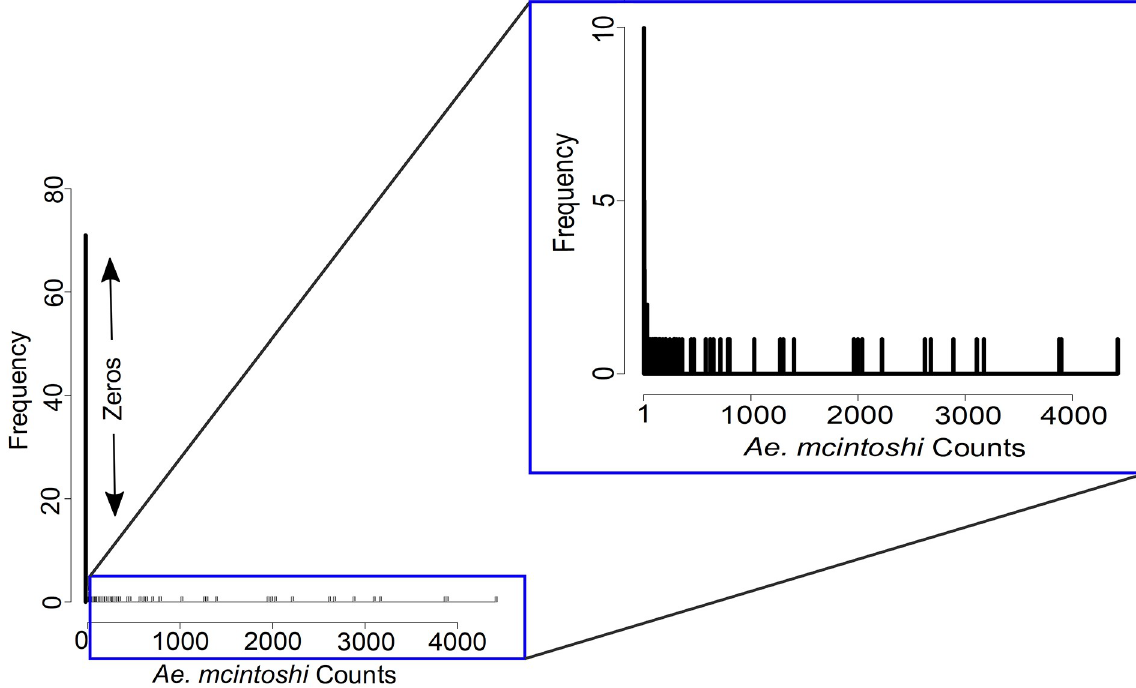
Fig 2. Count frequencies showing frequency of zeros; inset count frequencies from 1 to 4,426.